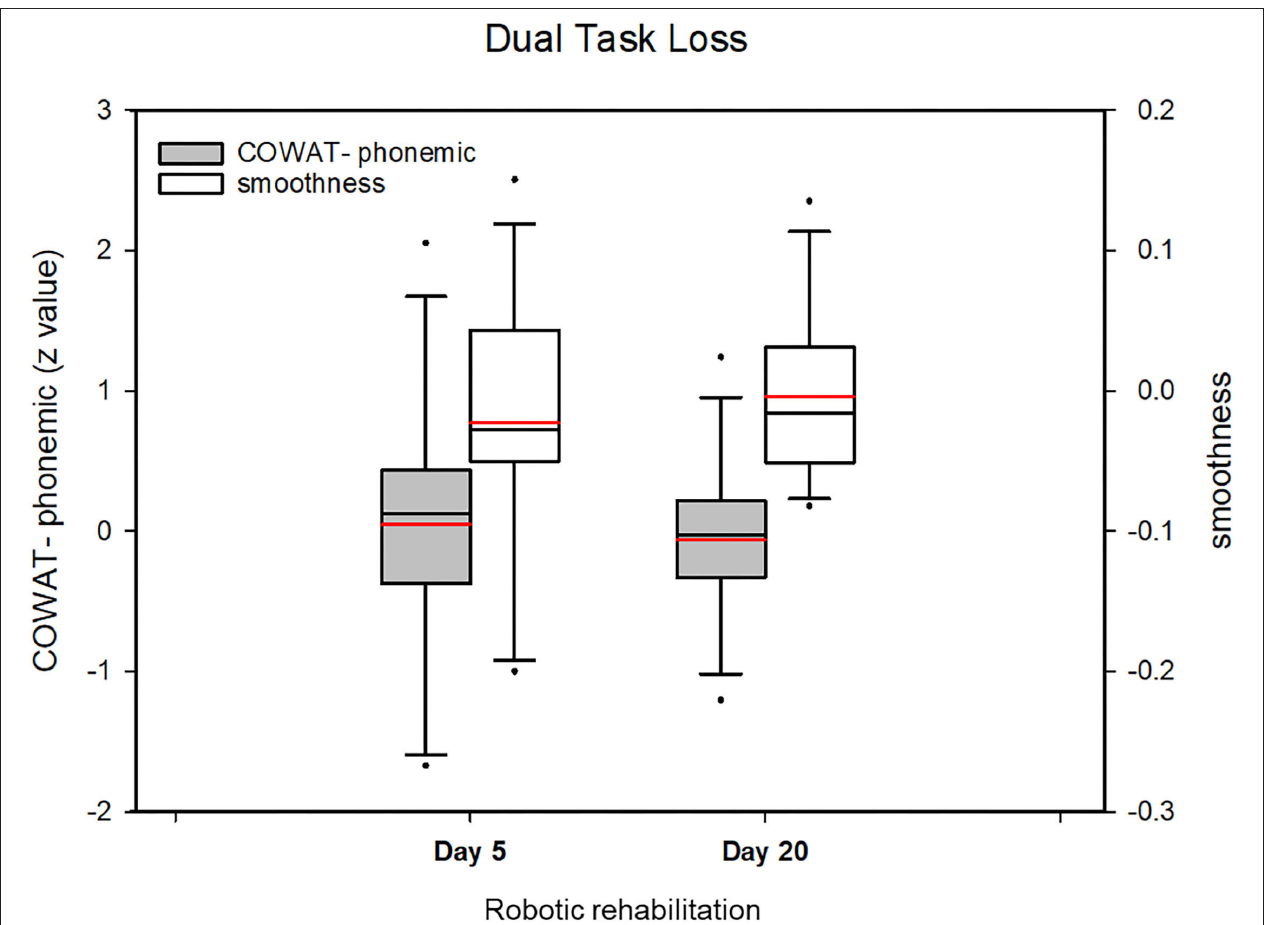
FIGURE 3 | Change of the dual task loss (DTL) value (COWAT_phonemic and smoothness) after robotic rehabilitation of the upper limbs. The DTL sum for cognitive and motor function did not change. The DTL sum for cognitive and motor function did not change. Boxplots represent the mean of z -values for each group during the course of robotic rehabilitation. Boxplots display lower and upper extremes, lower and upper quartiles, and medians. Red line in boxplots indicates the mean. The black whiskers mark the 5th and 95th